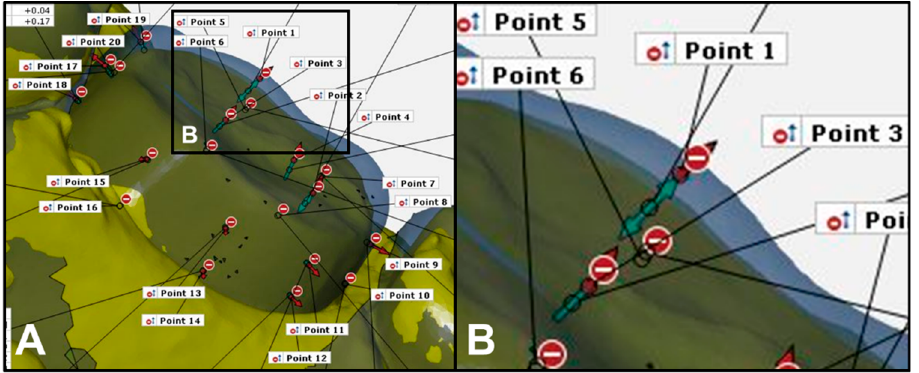
Figure 6. 3D overlap of Model C (blue color) and Model D (yellow color): ( A ) reference points were set as follows: 2 points each in the occlusal cusp and occlusal fossa, 4 points on the proximal surfaces (2 points each on the mesial and distal surfaces), 4 points on the smooth surfaces (2 points each on the buccal-and lingual surfaces), and 8 points on the line angles (2 points per mesiobuccal, distobuccal, mesiolingual, and distolingual line angles); ( B ) high-magnification image of the square region of Point 1. The green arrow indicates the distance between the ideally and actually prepared teeth.